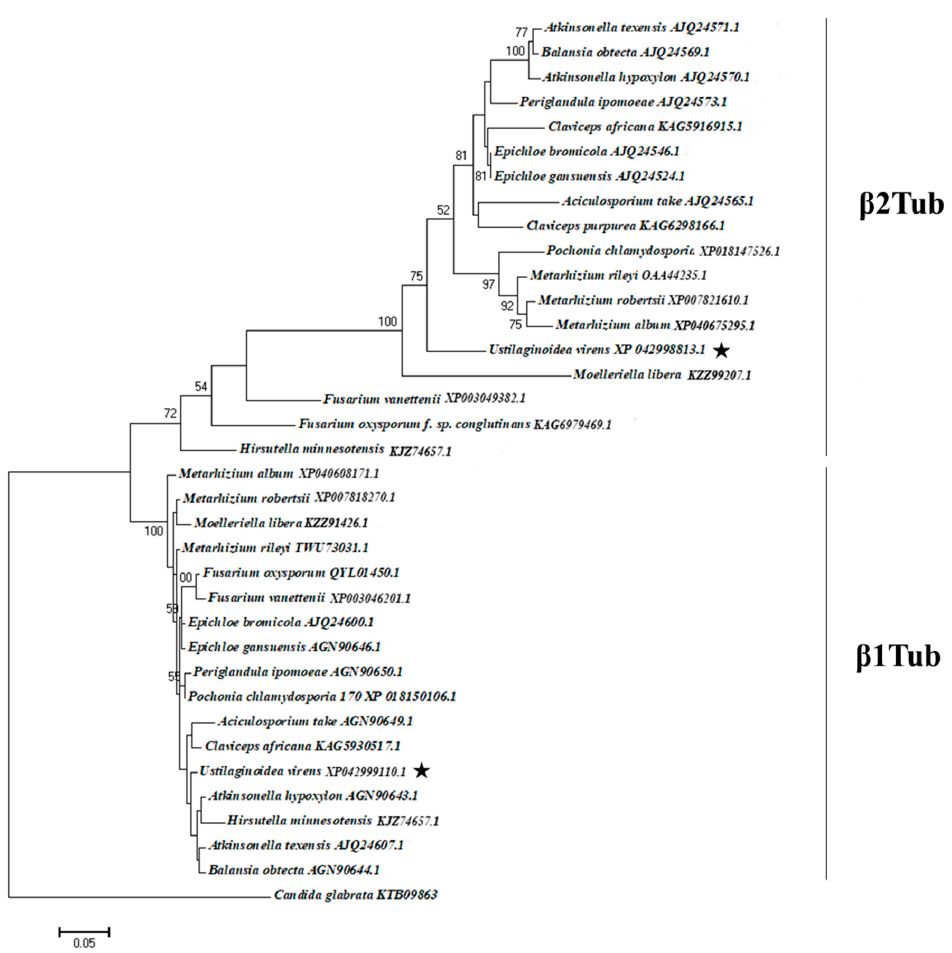
Figure 7. Phylogenetic tree generated by the maximum likelihood method with Mega 7.0 software [24] on the basis of deduced amino acid sequences of β -tubulin proteins. The deduced amino acid sequences of Uv β 1Tub and Uv β 2Tub for Ustilaginoidea virens isolate Uv8b and those from other fungal species, with 434 positions in the final dataset. Numbers labeled at each node indicate bootstrap values (%) from 1000 replicates. Stars indicate β 1Tub and β 2Tub of Ustilaginoidea virens in this study.